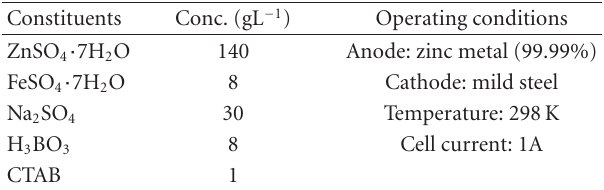
Table 1: Basic bath composition and operating conditions.